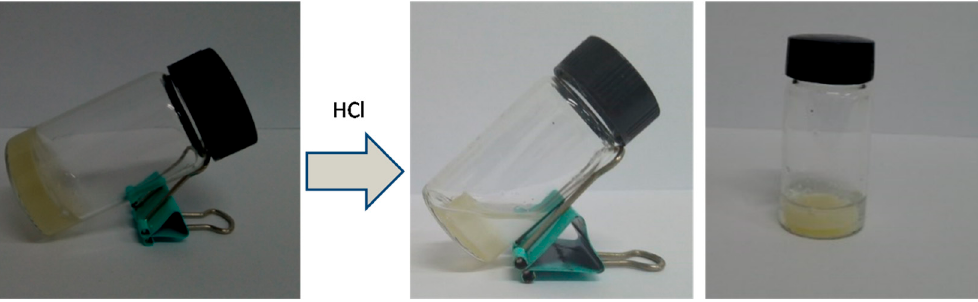
Figure 7. Dehydration of DTP/ADA hydrogel at pH = 1.